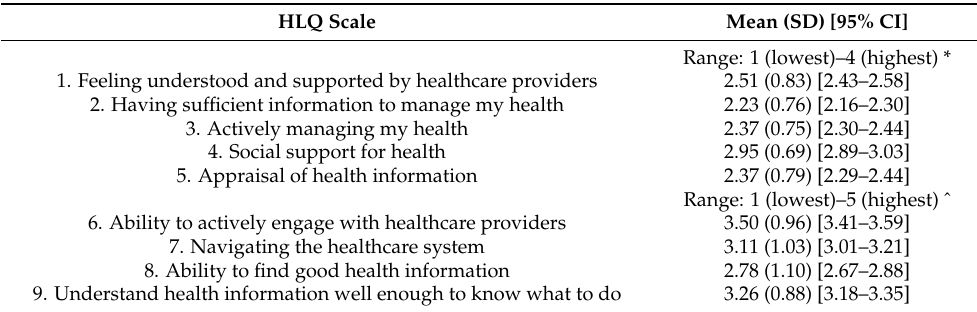
Table 1. Health Literacy Questionnaire (HLQ) scores of people from fishing communities in Borollos Lake region, Northern Egypt. HLQ Scale Mean (SD) [95% CI] Range: 1 (lowest)–4 (highest) * 1. Feeling understood and supported by healthcare